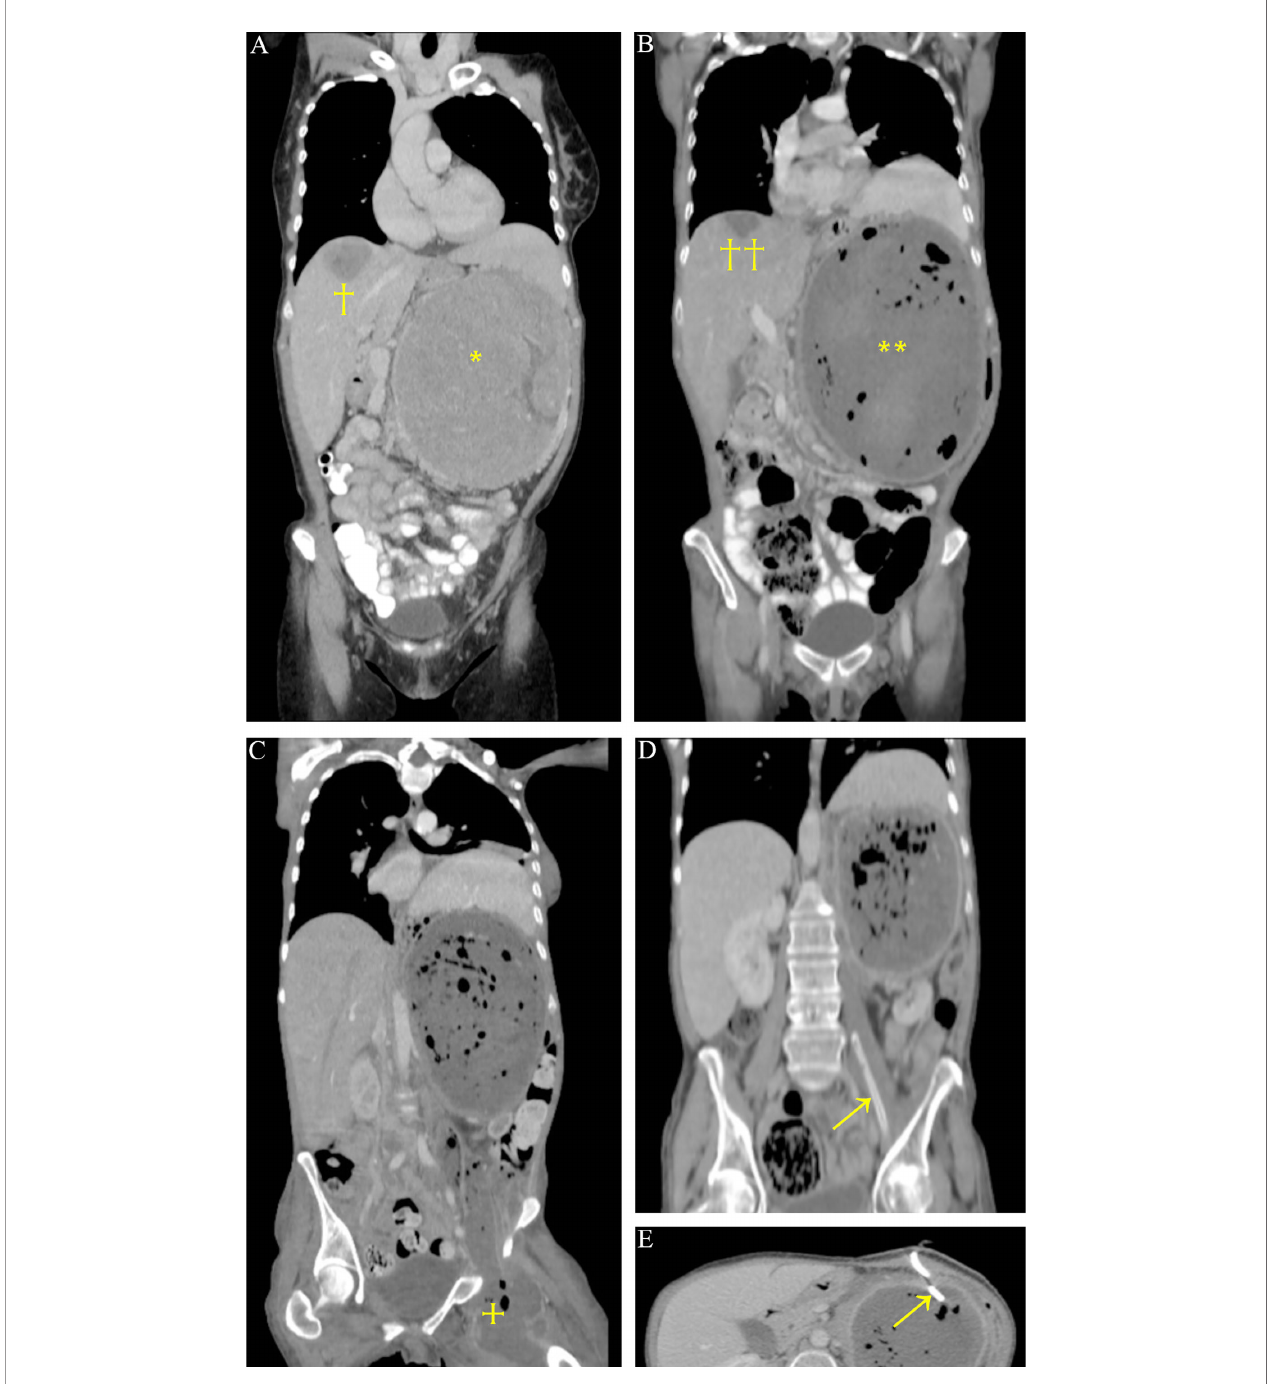
FIGURE 1 | CT scan of 20 cm large left adrenocortical carcinoma (*) with segment 8 liver metastasis ( † ). The segment 7 tumor is not shown on this reconstruction (A) . Necrosis on CT after liver TAE ( †† ) and embolization of the previously bleeding primary tumor (**) (B) . Abscess from the necrotic tumor reaching the thigh (+) (C) . Drains in the abscess (arrows); the descending part is already resolved (D,